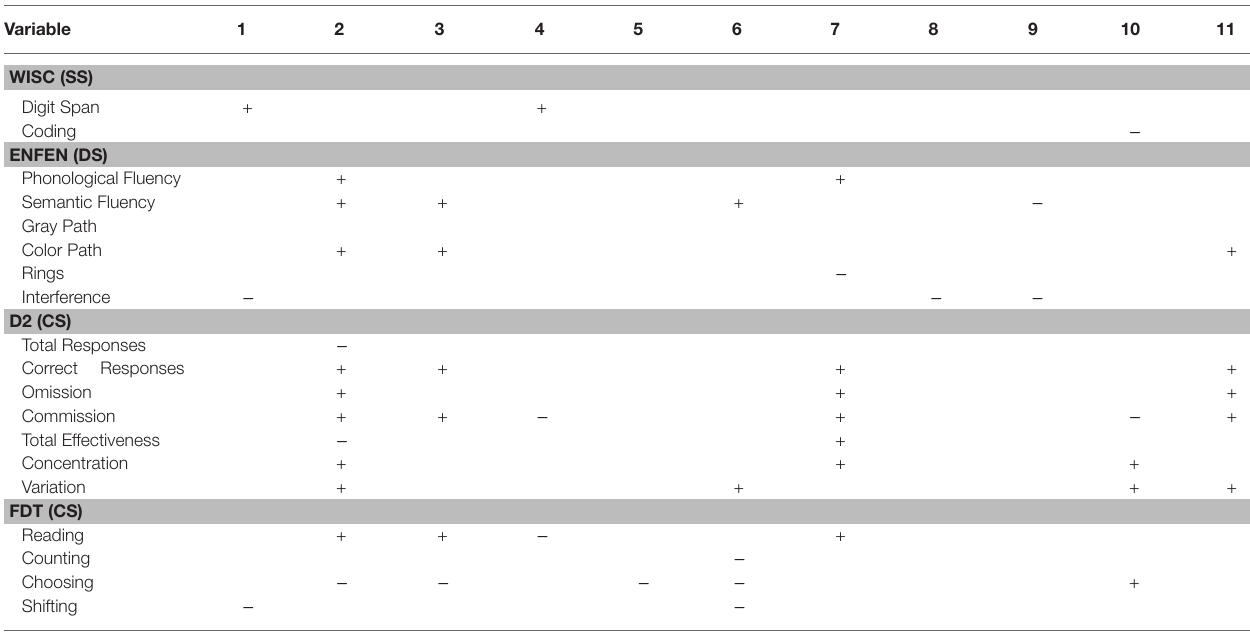
TABLE 4 | Reliable change index (RCI) post-pre program for each participant.